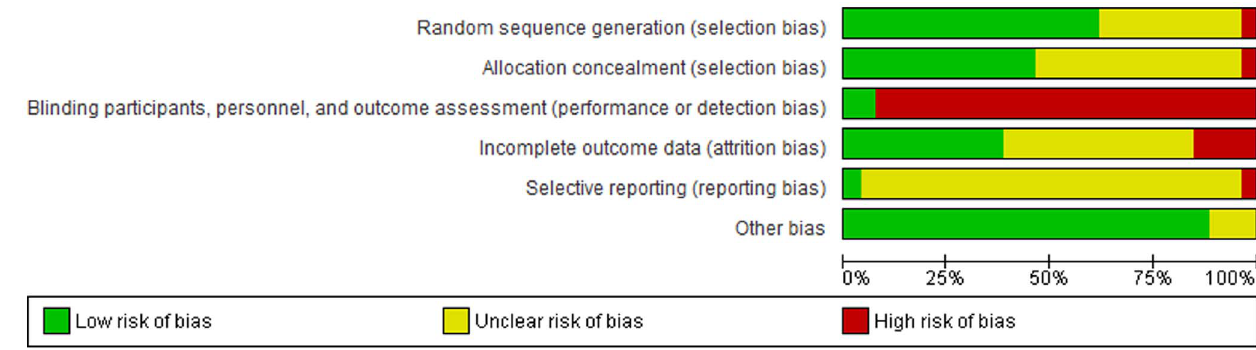
Figure 2. Risk of bias graph.